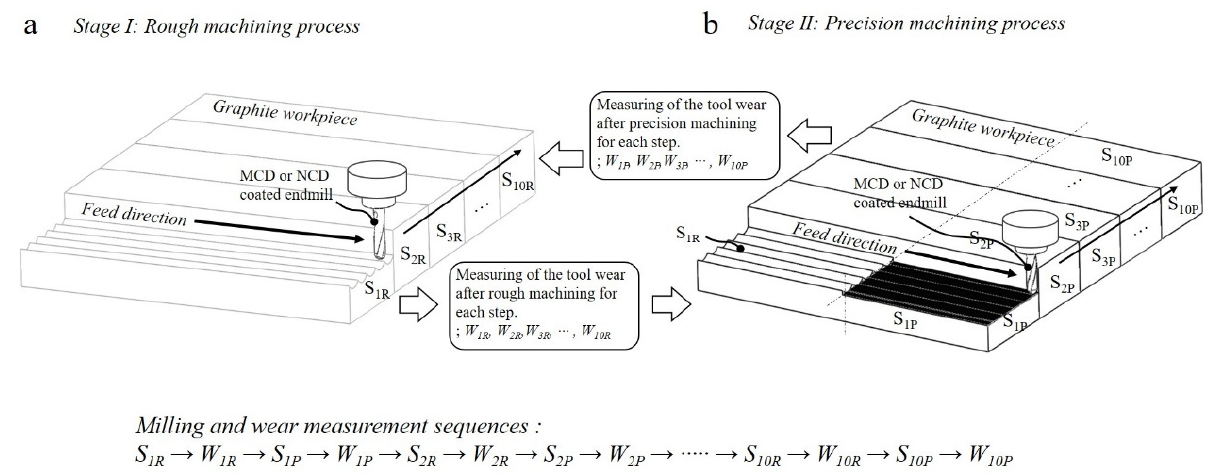
Figure 7. Sequence alternating milling processes of ( a ) rough and ( b ) precision machining.